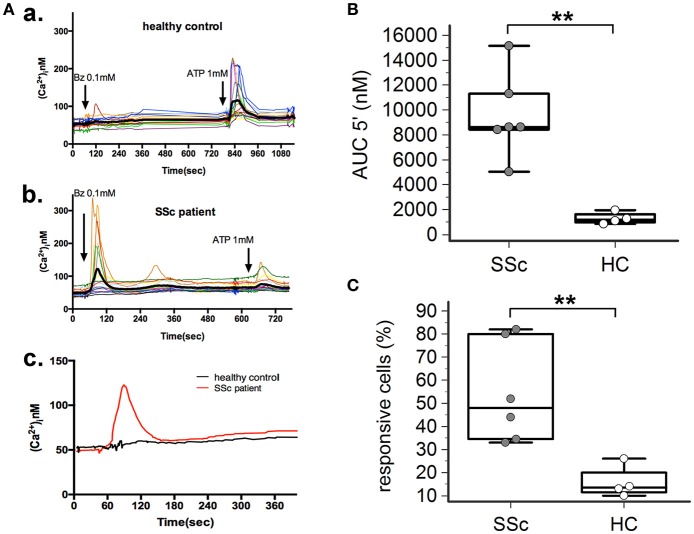
P2X7R-mediated calcium influx is enhanced in dermal fibroblasts from SSc patients. BzATP-induced calcium entry in dermal fibroblasts from SSc patients and HC, as determined by single-cell fluorescence microscopy. (A) Representative plot of an experiment in one SSc patient (a,c) and one HC (b,c). Each colored trace in (a,b) represents the response of individual cells while the thick black line in (a,b), and the red and black lines in (c) represent the mean response of all the cells from the same culture dish. The arrow indicates the time when the agonist was added. (B) P2X7-induced Ca2+ uptake as assessed by the AUC 5′, in dermal fibroblasts from SSc patients and HC. SSc patients, n = 6; HC, n = 4. **p < 0.01, two-tailed Mann–Whitney test. (C) Percentage of BzATP-responsive cells in SSc patients and HC. SSc patients, n = 6; HC, n = 4. **p < 0.01, two-tailed Mann–Whitney test. SSc, Systemic sclerosis; HC, healthy controls; P2X7R, P2X7 receptor; Bz, 2′-3′-O-(4-benzoylbenzoyl)ATP; Ca2+, calcium; AUC 5′, area under the curve represents the area enclosed between the curve of the [Ca2+]ìvs. the time for 5 min after the addition of the stimulus.